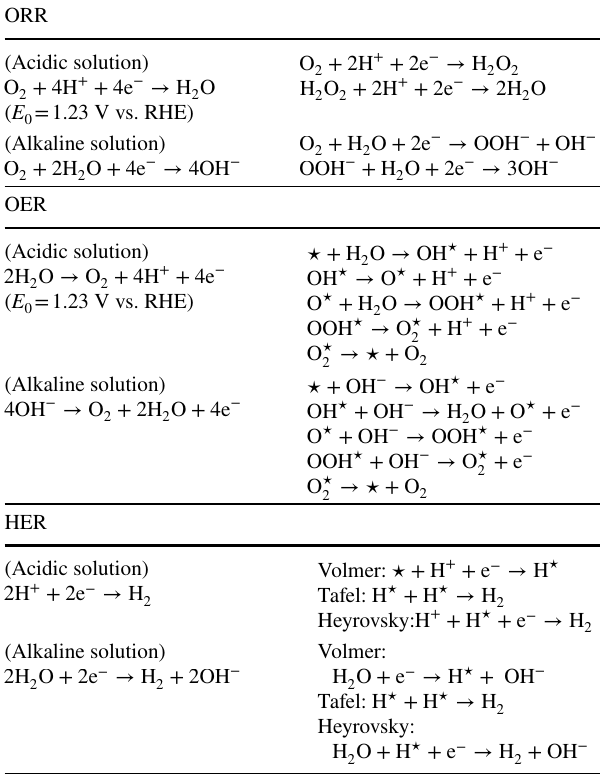
Table 1 ORR, OER, and HER overall reactions and the reaction pathways